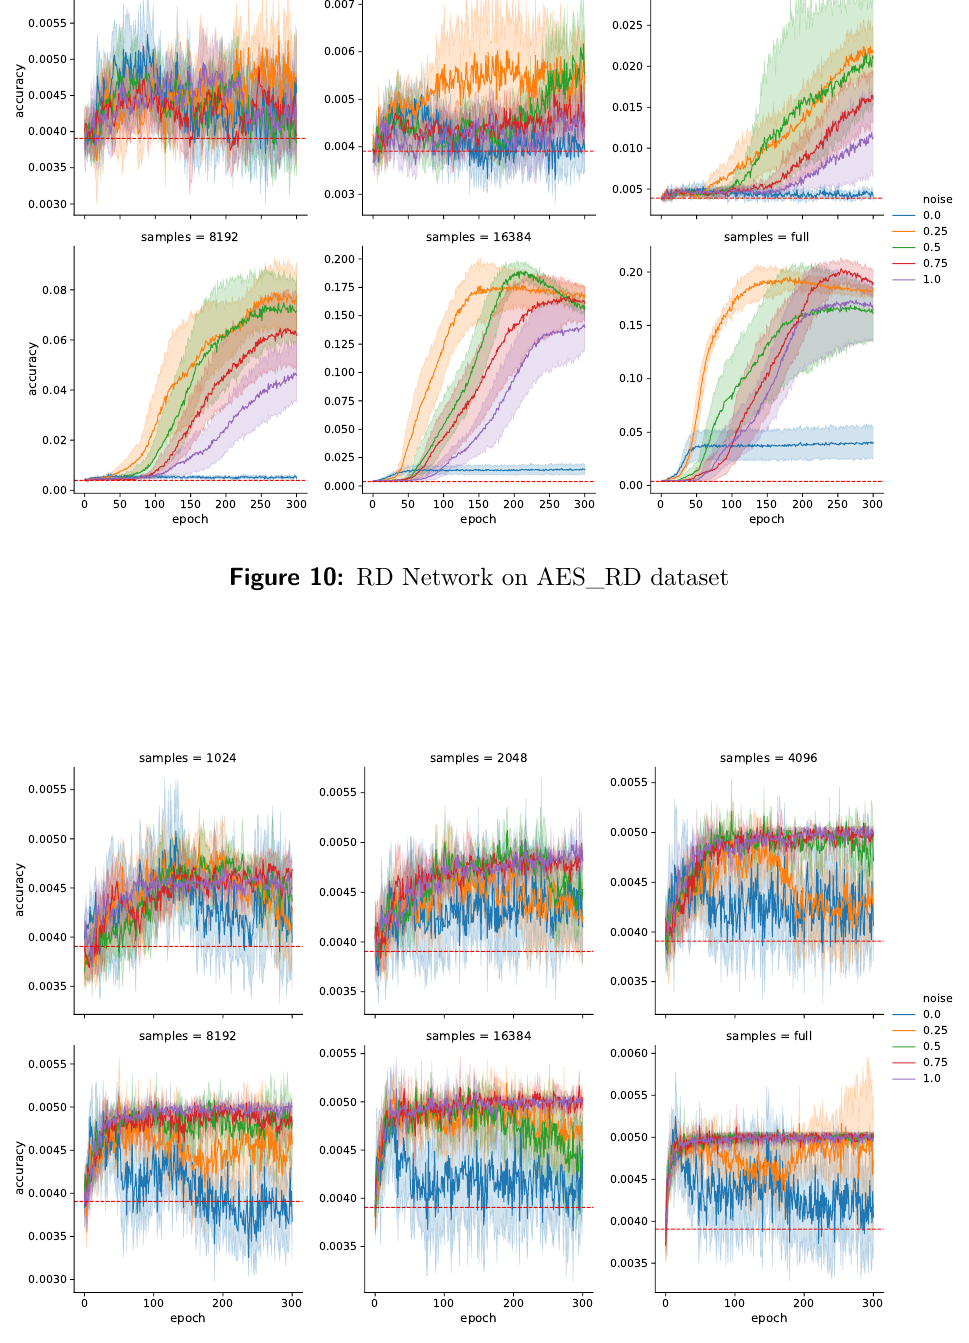
Figure 11: RD Network on ASCAD